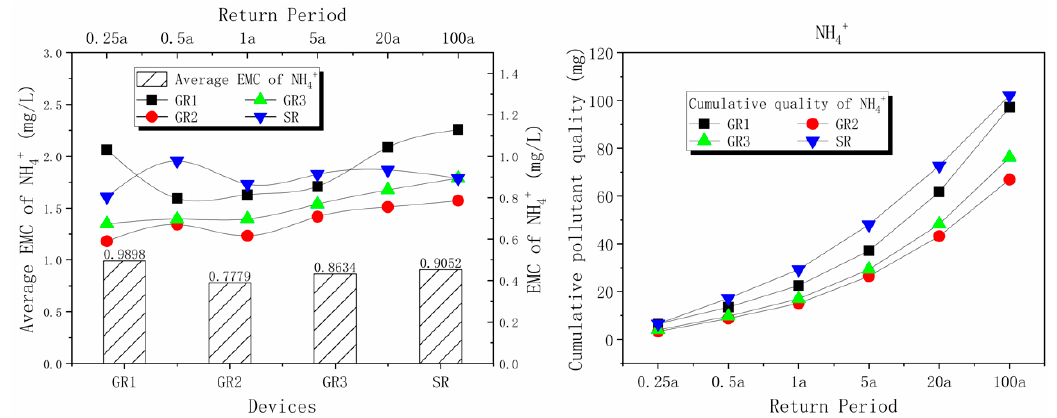
Figure 2. Event mean concentration (EMC) and cumulative pollutant quality of NH 4 + .